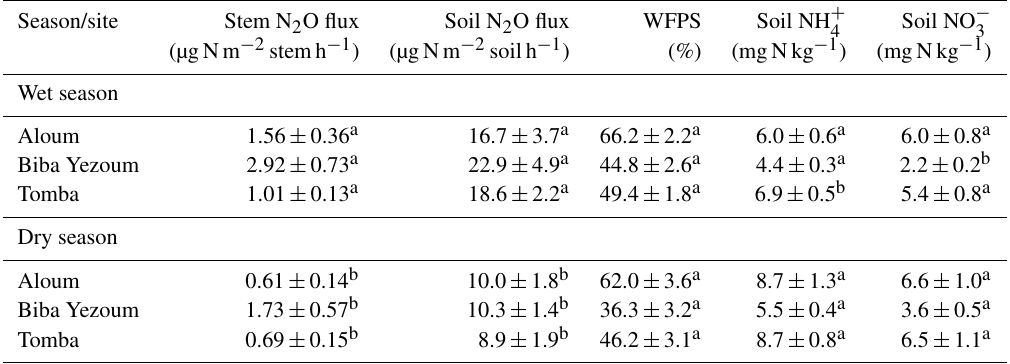
Table A3. Seasonal mean ( ± SE, n = 4) water-filled pore space (WFPS), extractable mineral N (measured in the top 5cm of soil) and nitrous oxide (N 2 O) fluxes in forests on highly weathered soils in the Congo Basin, Cameroon. Means followed by different lowercase letters indicate significant differences between seasons for each site (linear mixed-effect models with Tukey’s HSD at P ≤ 0 . 05).